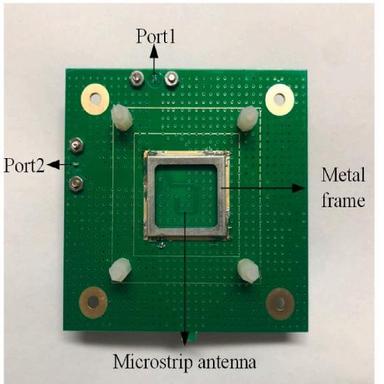
A microstrip antenna-based test fixture sample fabricated on PCB board.